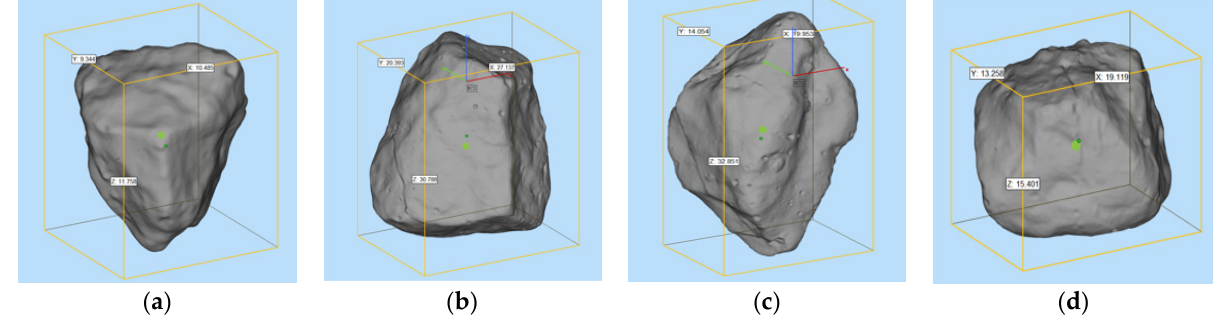
Figure 15. 3D scanning results of cement-based artificial aggregates ( a – d are random samples).